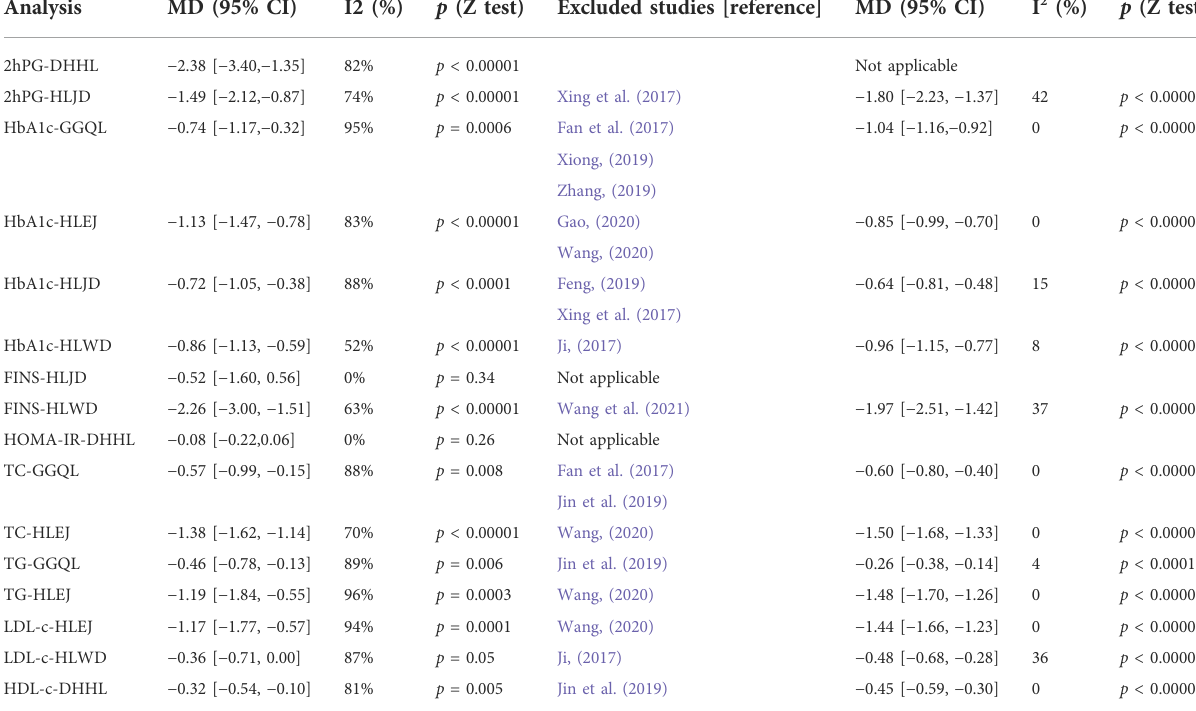
TABLE 4 Sensitivity analysis via excluding the under or over estimated